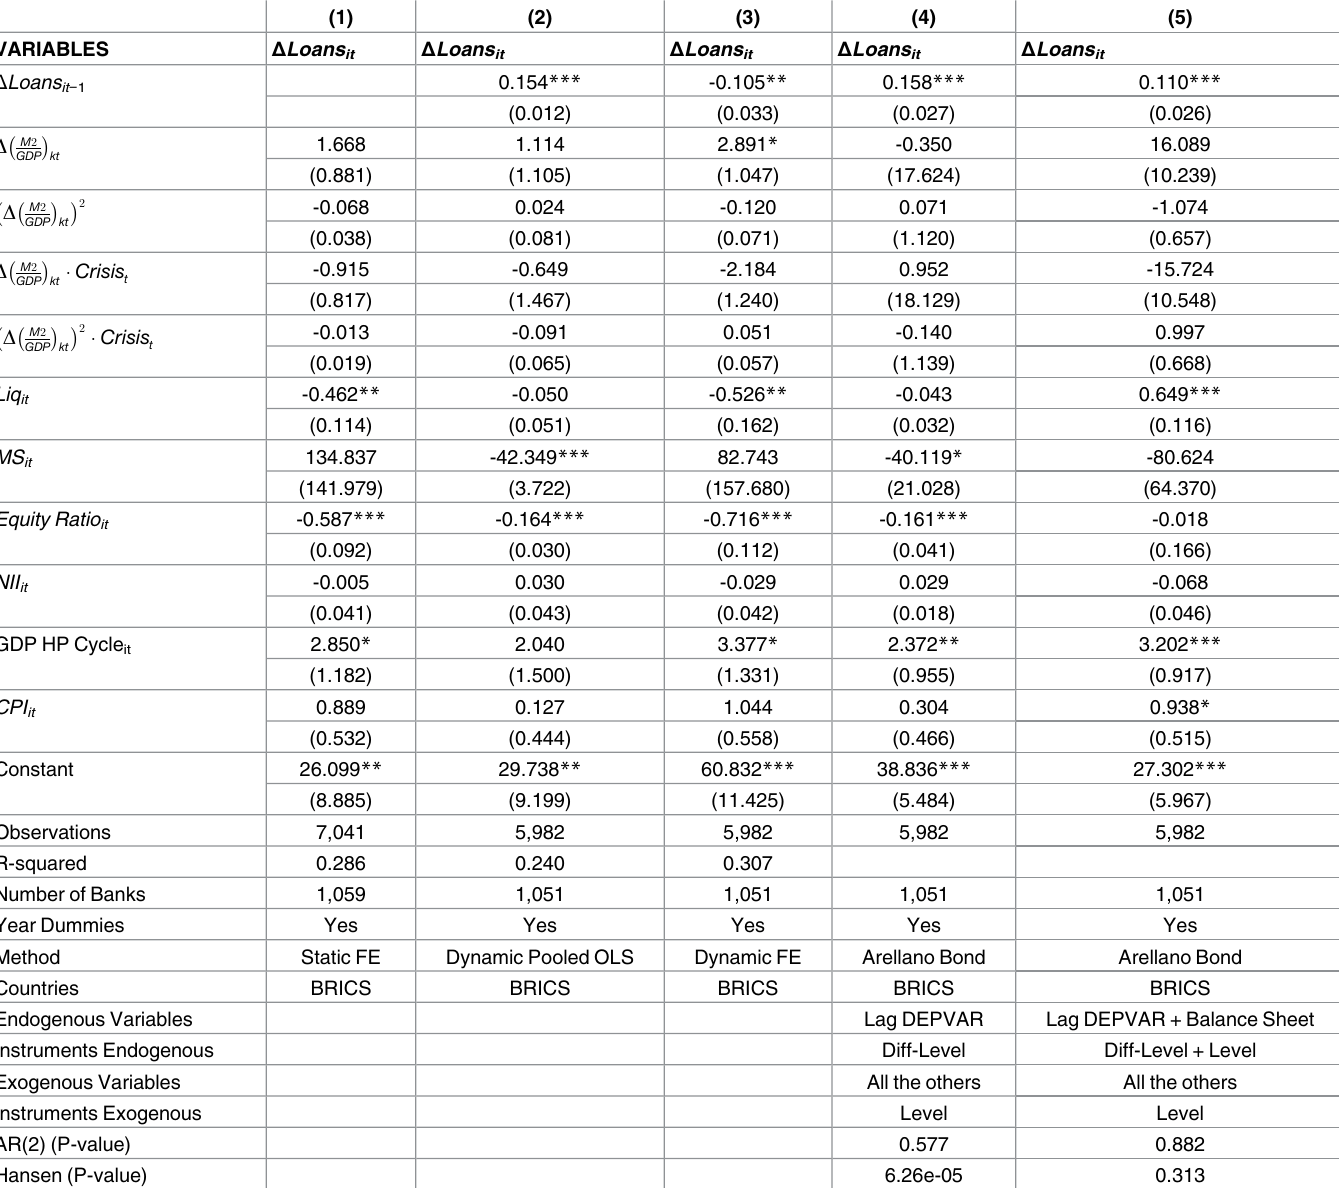
Table 5. Regression of Bank’s Loan Growth on Monetary Expansion D M2